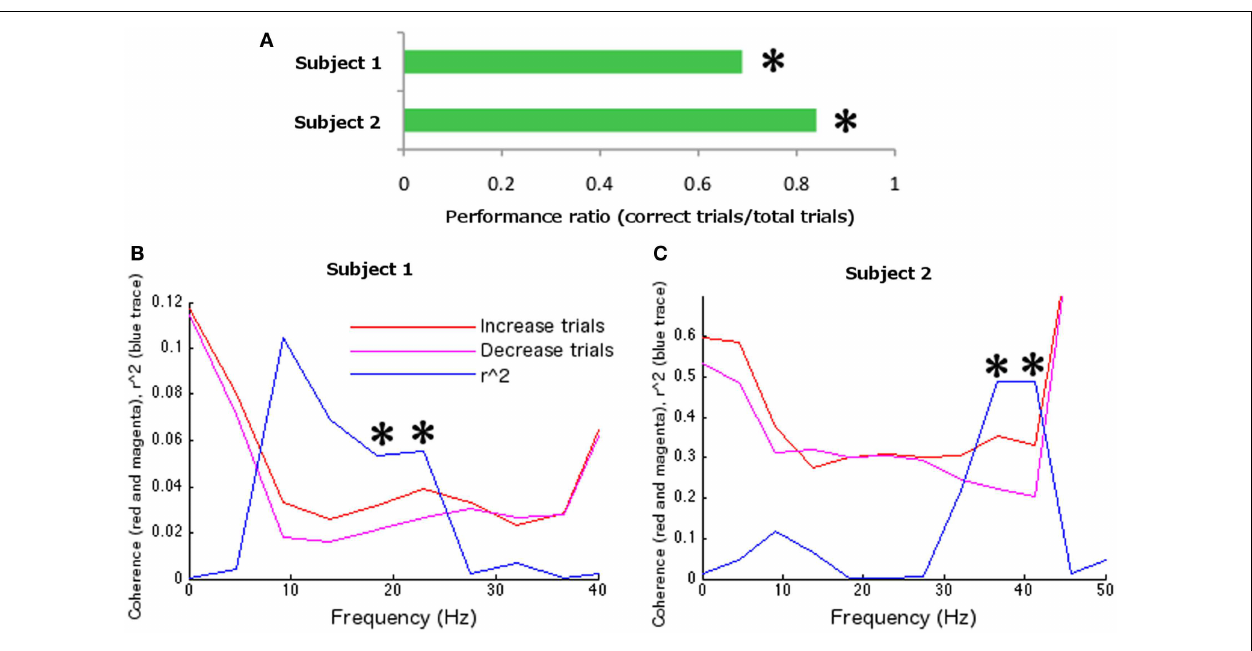
feedback testing between behavioral conditions across frequency (computed off-line). Asterisks indicate statistical significance at frequencies of interest, nearest to the